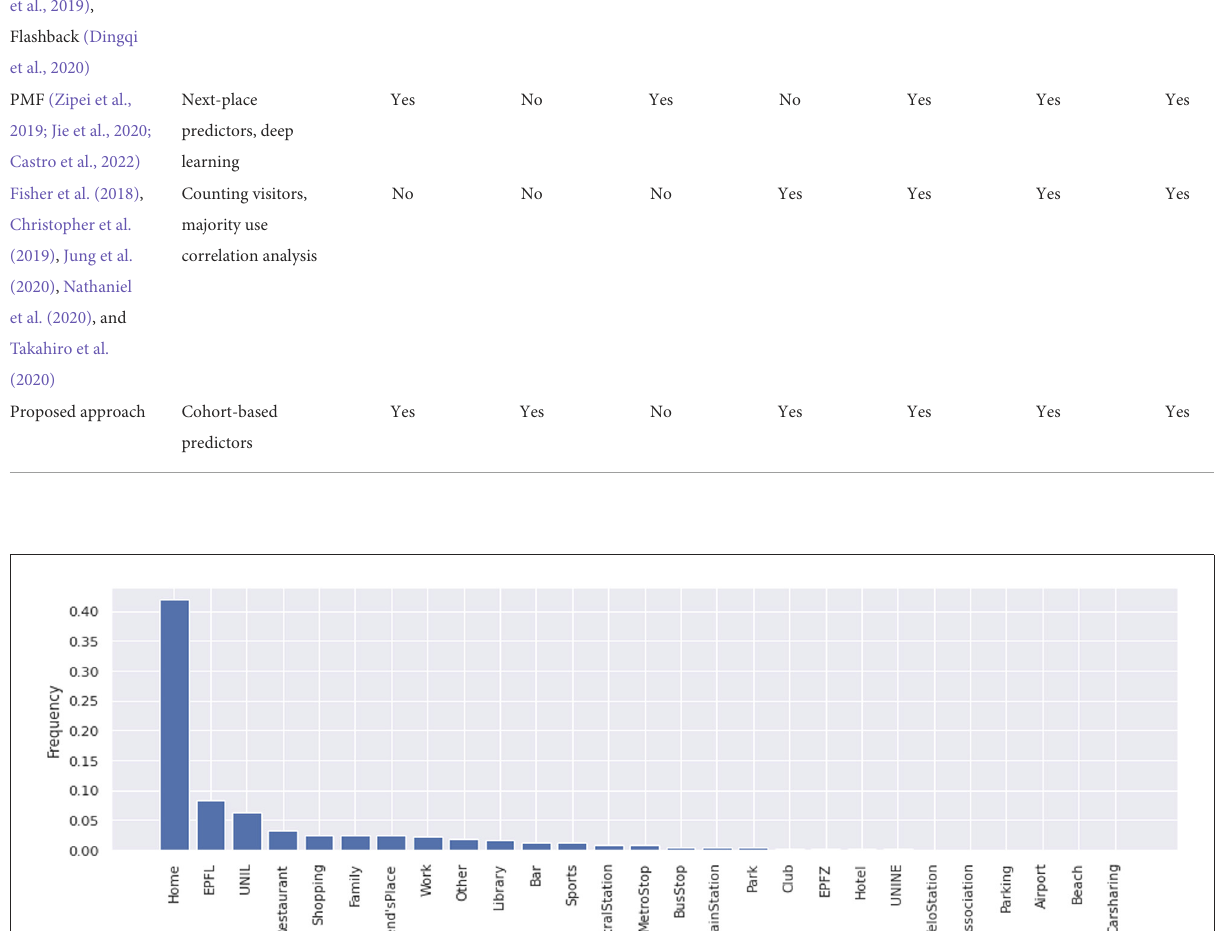
On- sensing demand sensing